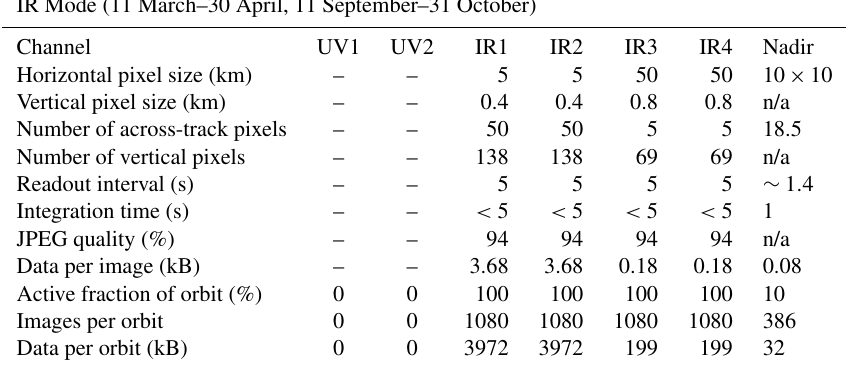
n/a: not applicable. Table 6. Preliminary scheme of the image readout in the six limb channels and the nadir channel during “IR mode”. Information about pixels refers to image pixels that are created from binning of the individual CCD pixels. The total image data amount to 8373kB per